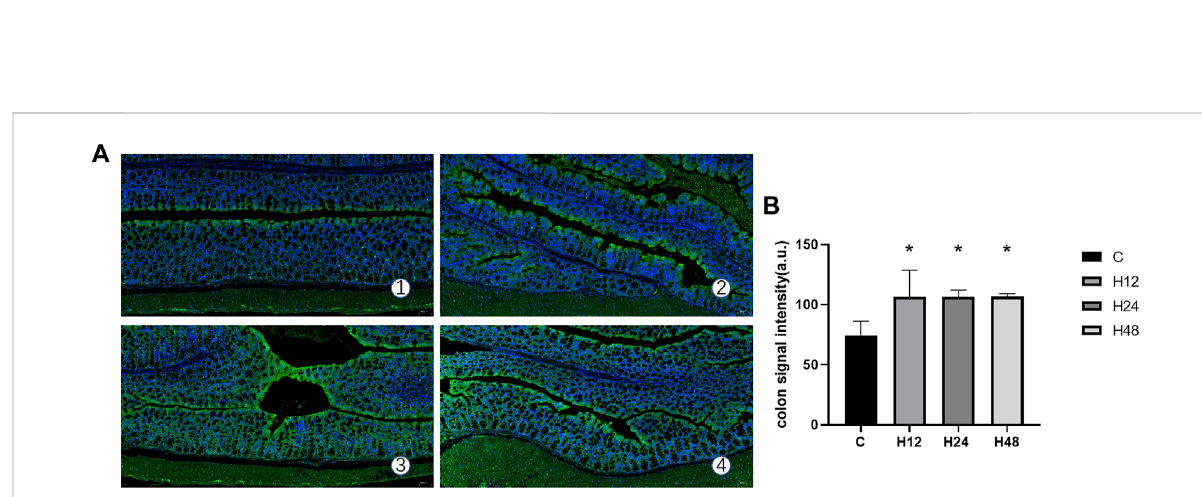
FIGURE 3 Hypoxia ofcolon tissue ineach experimentalgroup. (A) Expression ofhypoxia probe signal intensity incolon tissue ofeach experimentalgroup (10×), n =3. (B) Quantitativeexperimentalmapofcolontissuehypoxiaprobesignalintensitiesineachexperimentalgroup, n =3.1:C,controlgroup; 2:H12group, thehigh-altitude groupfor 12 h; 3:H24 group, high-altitudegroup for24 h; H48,high-altitude groupfor 48 h. Thedata arepresented as the mean ± standard error of the mean. * p < 0.05 vs . N group, ** p < 0.01 vs . C